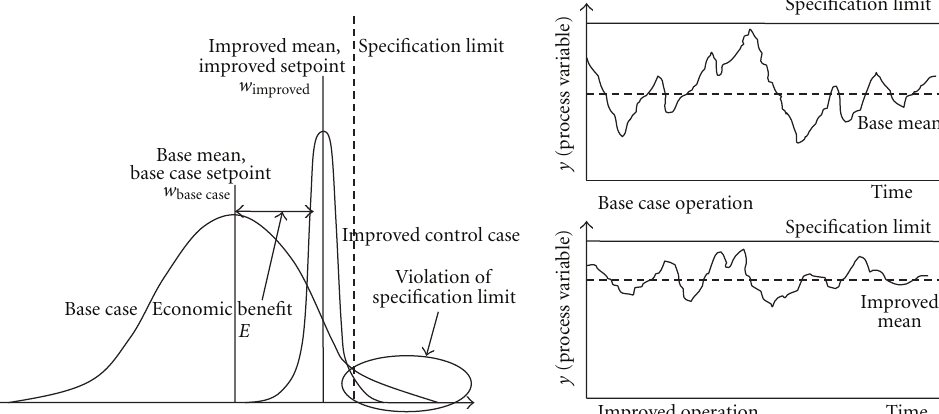
Figure 2: Approach to economic benefit estimation with variance